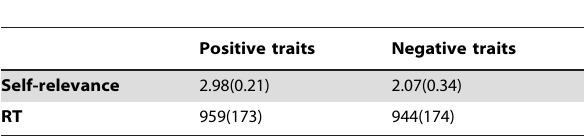
Table 1. Participants’ self-relevance scores and reaction times for positive traits and negative traits (32 samples, means and standard